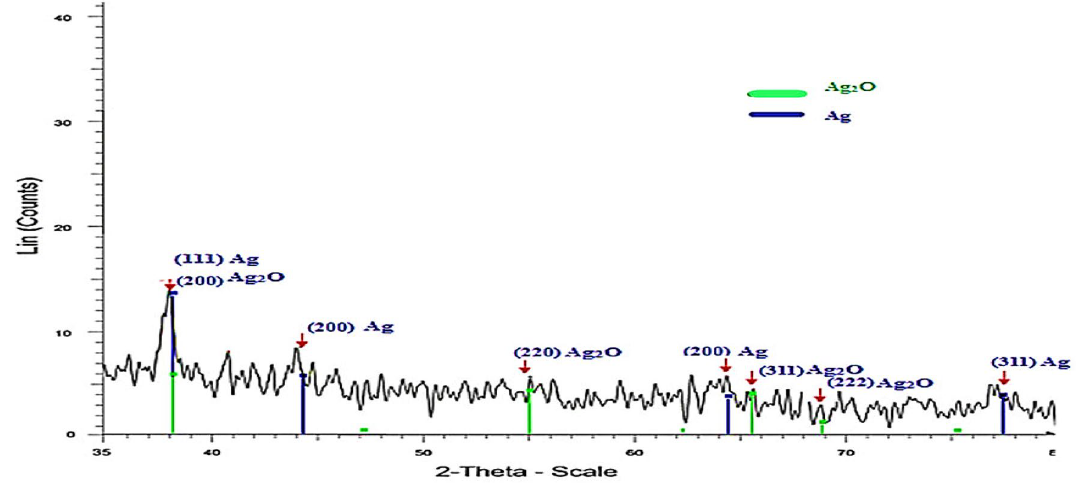
Figure 5. Typical XRD pattern of silver nanoparticles stabilized in